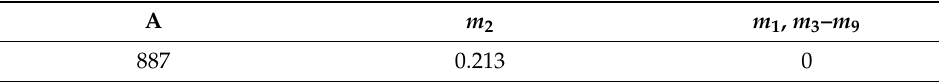
Figure 8. Comparison of the flow stress equation curve with the Hansel–Spittel equation. Table 3. Coefficient of Hansel–Spittel equation for 34CrMo4.